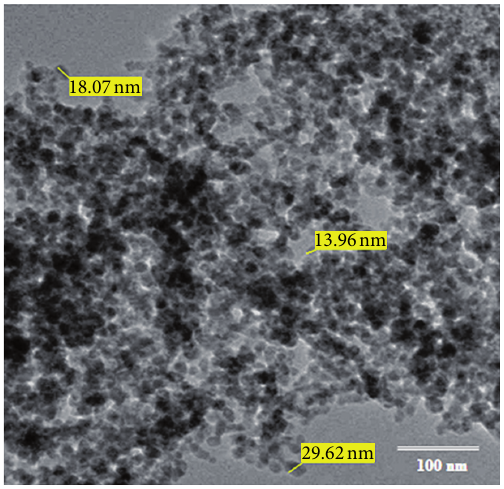
supported catalyst. F 7: TEM image of Ru/ -supported